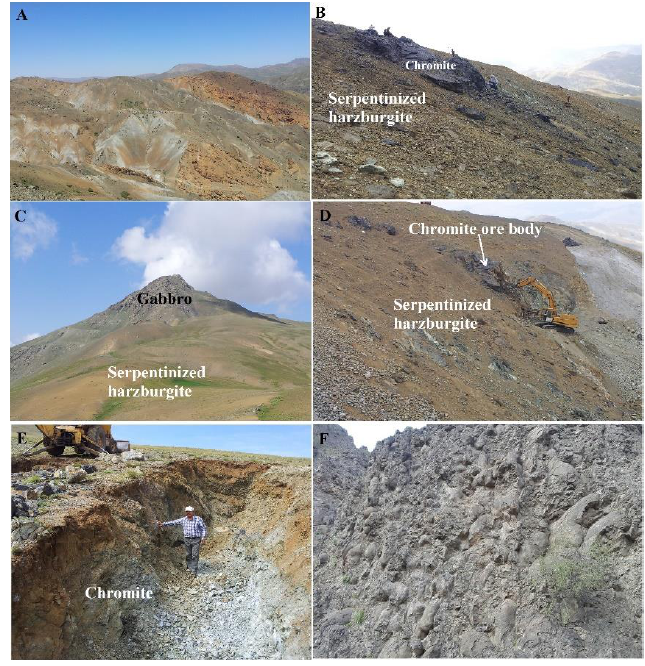
Figure 2. Field photographs show: ( A ) serpentinized harzburgite; ( B ) lens-shaped chromite within serpentinized harzburgite; ( C ) gabbroic intrusion within the ultramafic rocks; ( D ) chromite ore body; ( E ) chromite ore body within serpentinized harzburgite covered by overburden; ( F ) basaltic pillow lava.